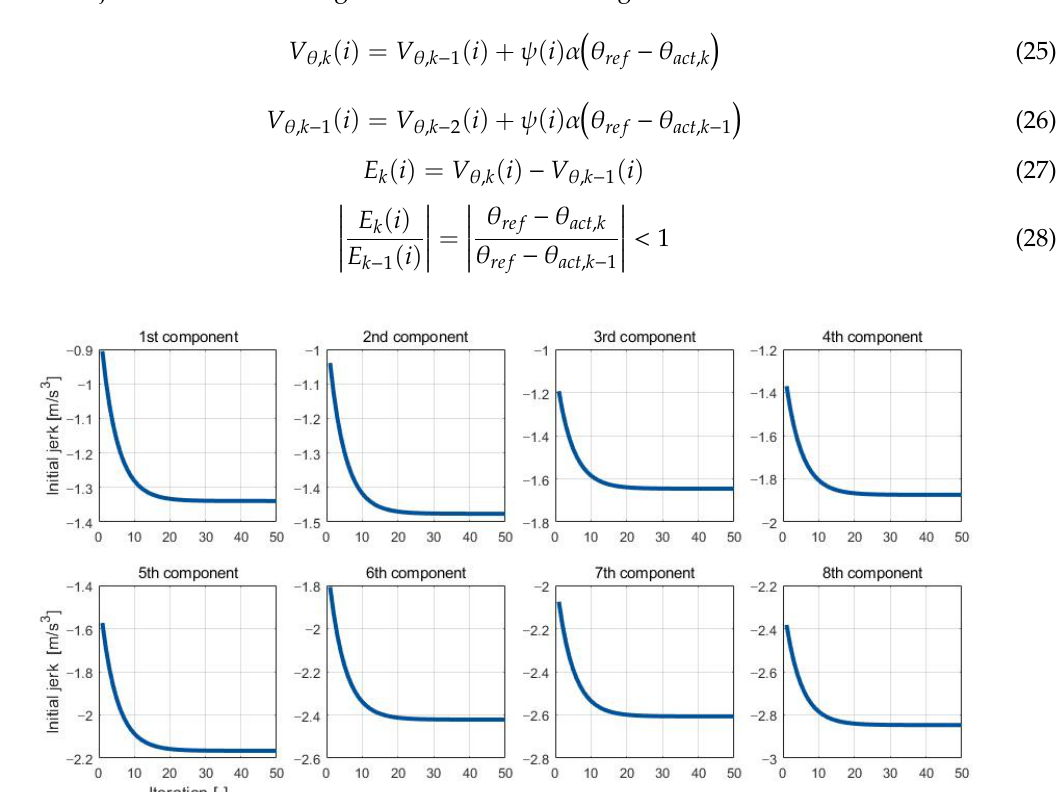
Figure 11. Convergence of learning vector when learning rate is 0.2. Table 5. Values of learning rate according to the driver parameters.